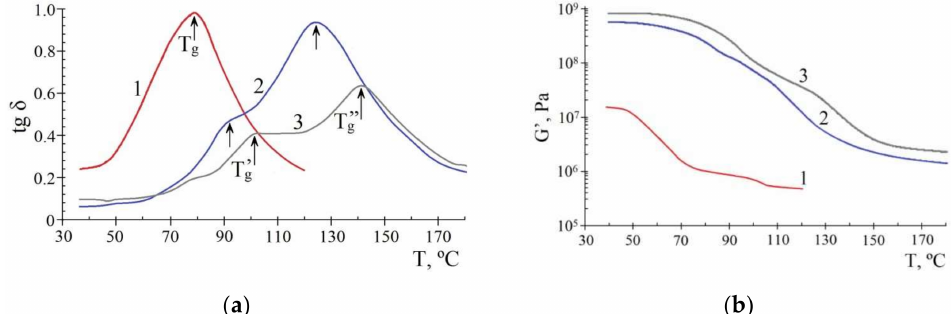
Figure 5. The effect of FMF on the tangent of an angle of mechanical losses tg δ ( a ) and the storage modulus G’ ( b ) of pHEMA-gr-PVP copolymers (HEMA:PVP = 80:20 mass parts; [Me] = 10 wt.%; T g ’ —Glass transition temperature in volume, T g ” —Glass transition temperature at the phase bound- ary): 1—Unfilled copolymer; 2—Co; 3—Ni.